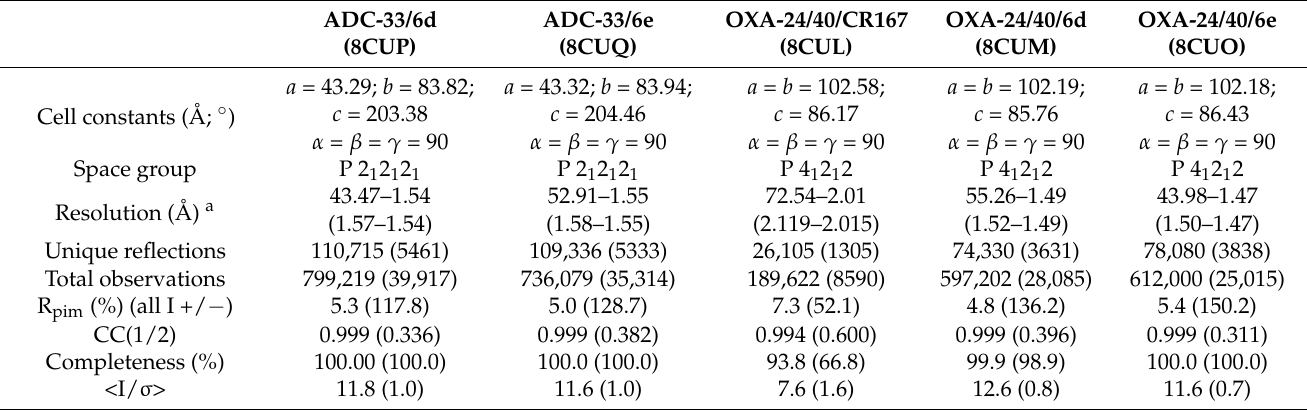
Table 2. Crystallographic statistics for ADC-33 and OXA-24/40 inhibitor